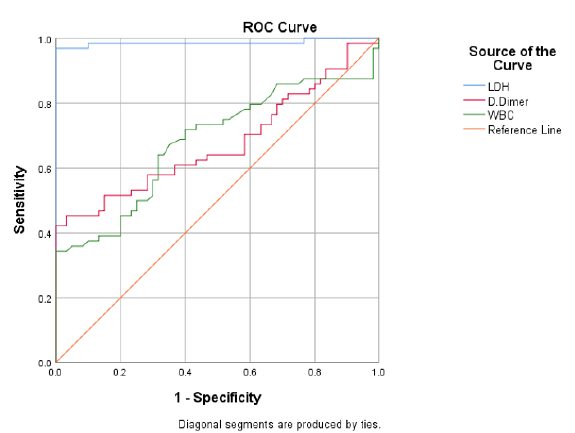
Fig. 1. ROC curve for lab